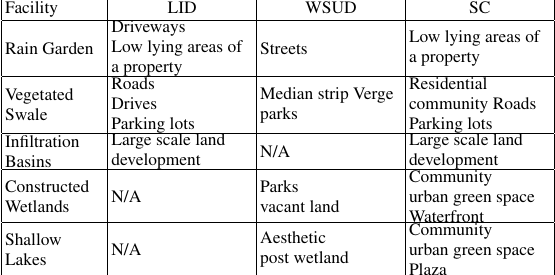
Table 1. Applied region of sustainable stormwater management facilities